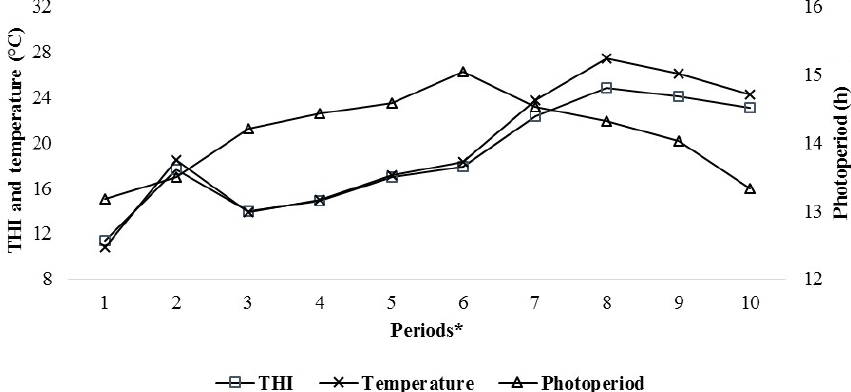
Figure 1. Changes in the average temperature, the temperature–humidity index (THI) and the photoperiod during the experimental periods. ∗ The first samples (Period 1) were taken 14–15d after birth, and the other samples (periods 2–10) were then carried out at 15d intervals.